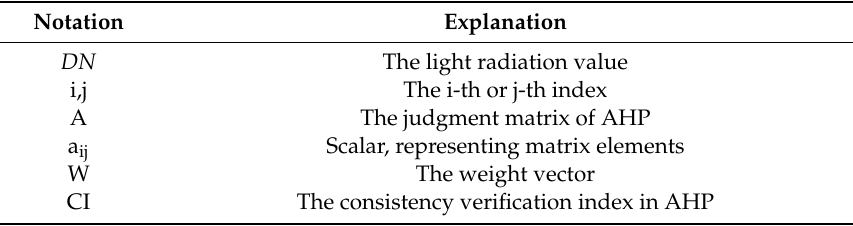
Table A1. Notations used in this